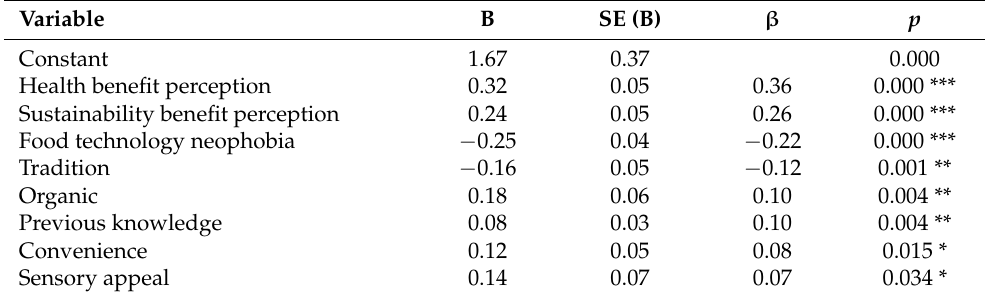
Table 4. Results from multiple linear regression analyses explaining respondents’ final attitudes toward